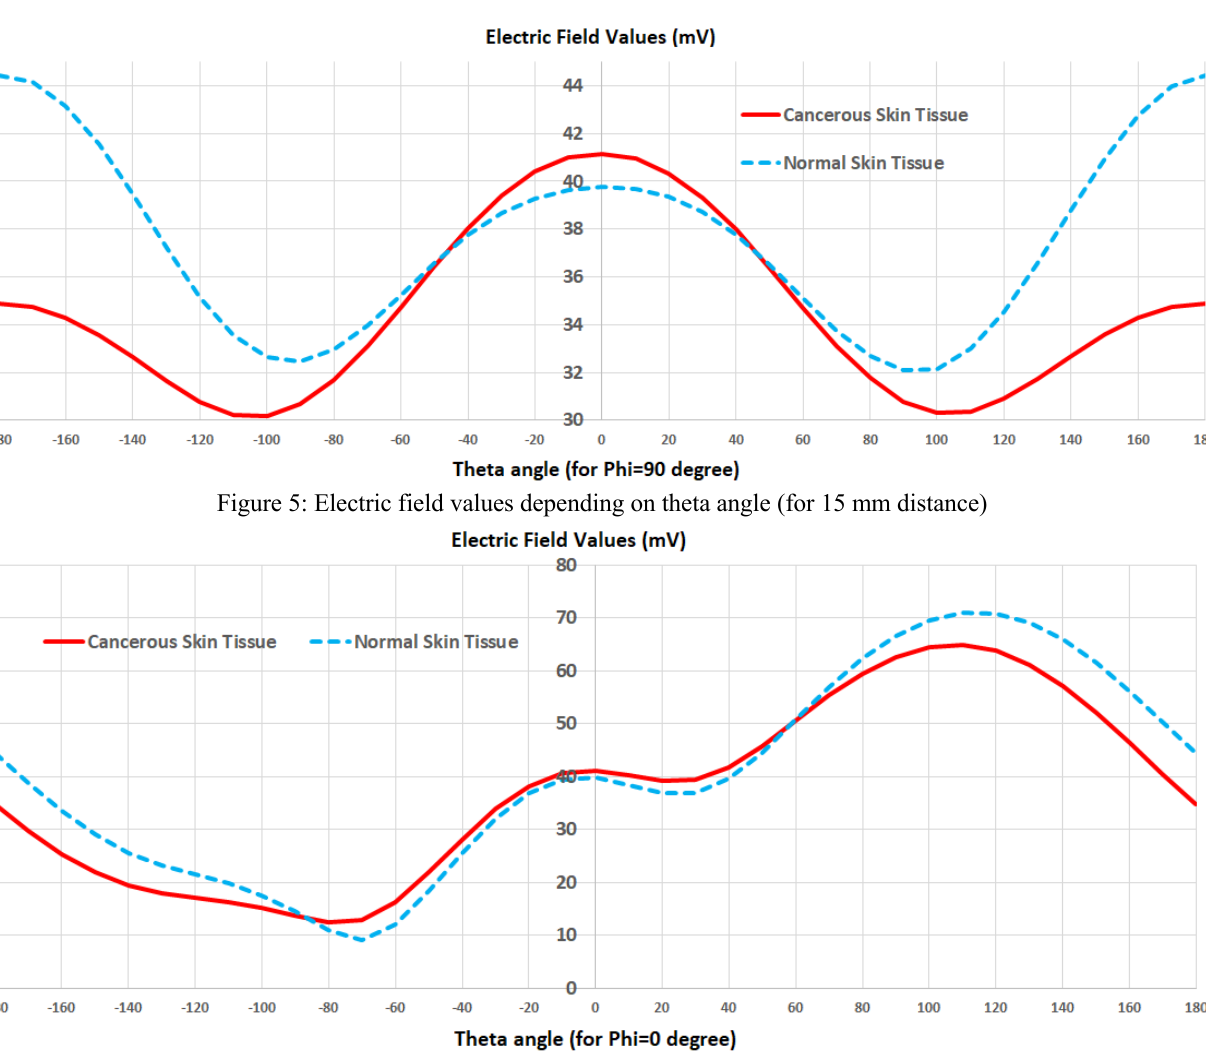
Figure 6: Electric field values depending on theta angle (for 15 mm